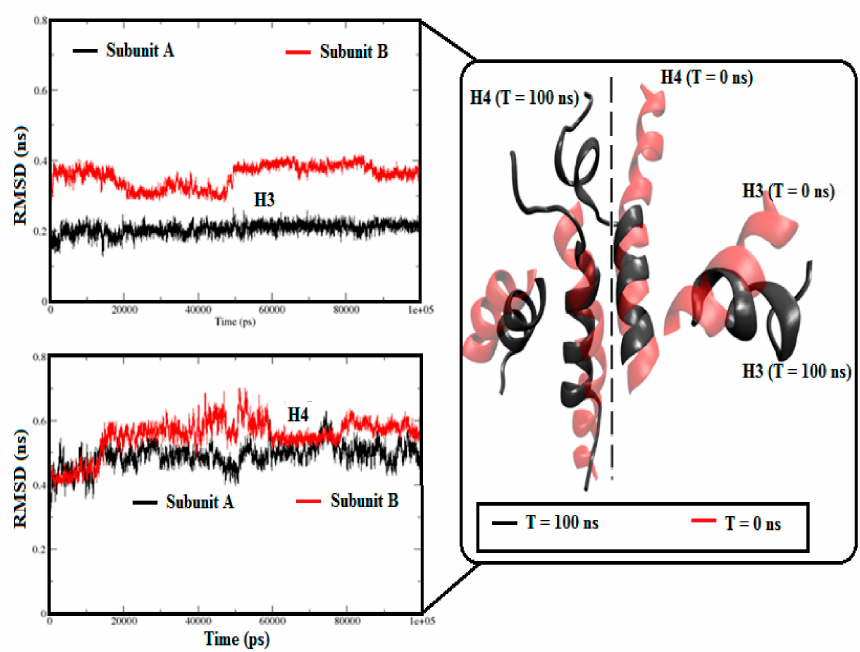
Figure 2. RMSD approximations of H3 and H4 domains in both subunits of the holo-S100A1 system. RMSDs of H3 and H4 domains of the two sides are represented in a red and black color code. A comparative superimposition between the structure of T = 0 ns (cartoon in red) and T = 100 ns (cartoon in black) of H3 and H4 of the two sides. Comprehensible structural transitions can be seen after simulation.